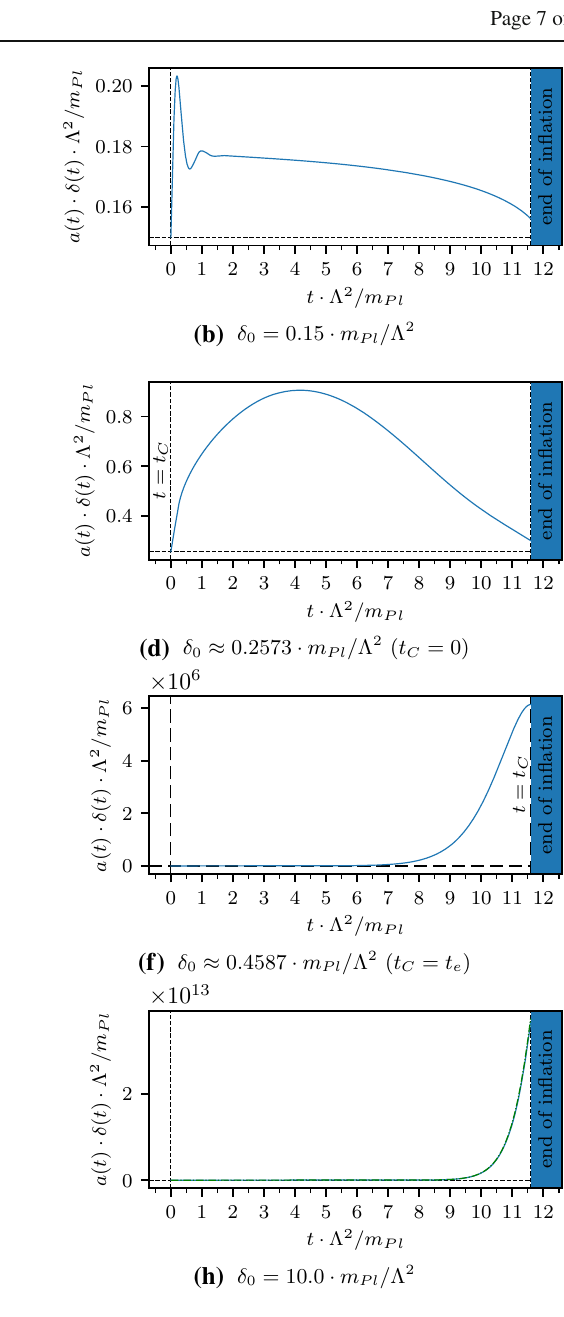
Fig. 5 Time dependence of physical thickness of the wall, a ( t ) · δ( t ) , for different values of the initial wall thickness, δ 0 , in the “hilltop” model. Here t , a ( t )δ( t ) and δ 0 are shown in m Pl /(cid:12) 2 = ( 10 − 6 m Pl ) − 1 units. Dashed horizontal line corresponds to δ 0 . The time at which the